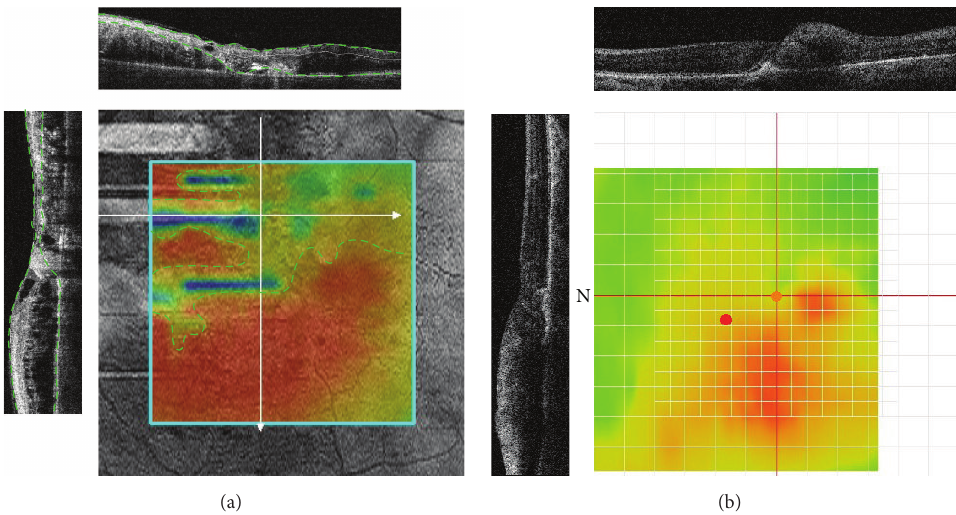
Figure 1: Artifacts in OCT retinal thickness maps that impede OCT-guided planning for navigated MLP. (a) Incorrect automated segmentation (in B scans, a green dashed line represents automated segmentation boundaries; white arrows on the map indicate the locations of B scans) resulting in the occurrence of zones with underestimated retinal thickness (indicated by map colors colder than red and limited by a yellow dashed line). (b) Off-center artifact due to fixation error (green mark represents the true foveal center identified with B scans; red mark represents the foveal center identified automatically; black lines on the map represent the locations of B